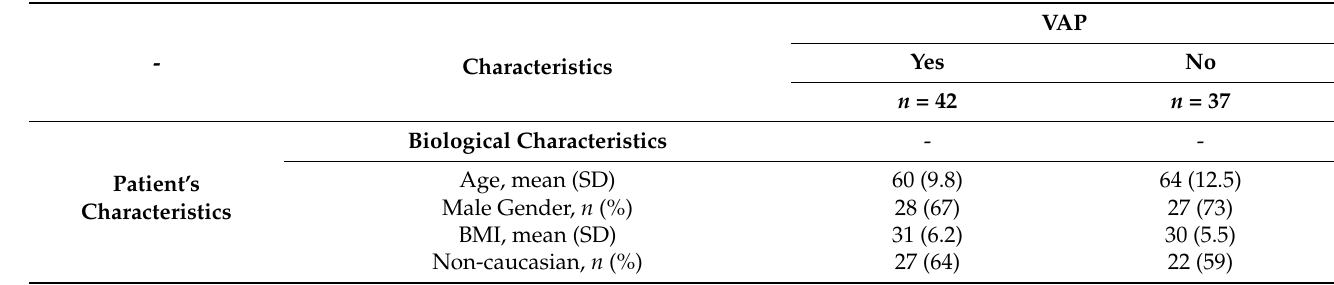
Table 3. Characteristics of patients with SARS-CoV-2 infection receiving mechanical ventilation and experiencing or not experiencing ventilator-associated